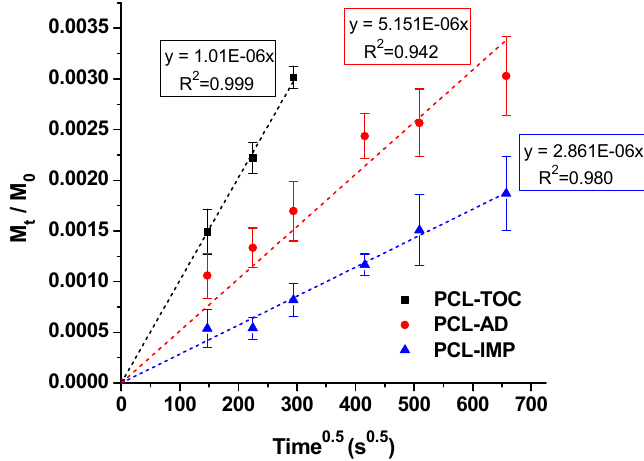
Figure 4. Mass fraction versus the square root of time and curves fitted for α -tocopherol released from PCL-based films into 50% ethanol. Dotted curves represent the migration model fitted to the corresponding experimental data points.